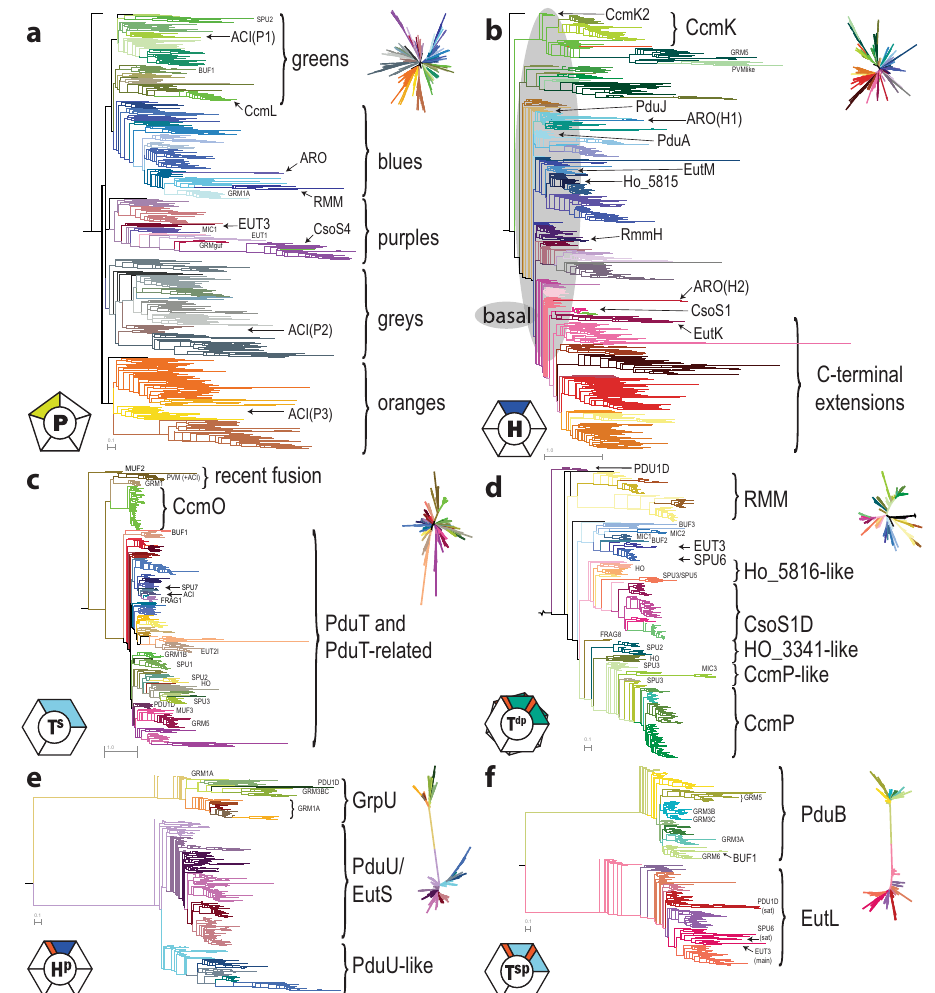
Fig. 3 Phylogenetic maximum likelihood trees for the six types of shell protein. a BMC-P, b BMC-H with the region of basal hexamers encompassed by gray shading, c BMC-T s , d BMC-T dp , e BMC-H p and f BMC-T sp . Representative sequences were selected by removing redundancy. Full hi-resolution images of each tree with annotation labels for all terminal nodes are available as Supplementary Data 1. All caps labels refer to the predominantly associated locus with a certain BMC type, mixed case labels denote a speci fi c, previously characterized protein found in that clade. For BMC-P the major clades are labeled by color. Unrooted versions of the trees are shown in the top right corner of each